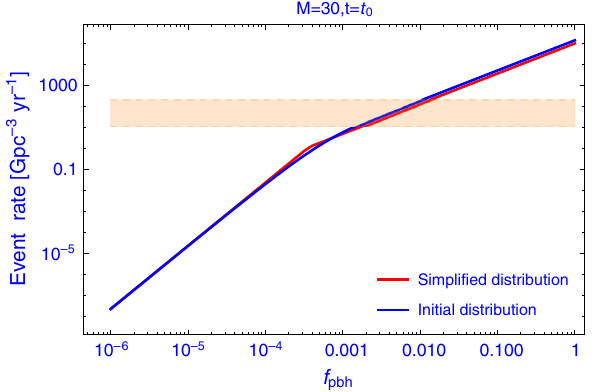
Fig. 1 Event rate of single-mergers of PBH binaries with the mass of 30 M (cid:2) asafunctionofthePBHabundance.Thebluelinecorrespondsto the case of the distribution (7) and the red line corresponds to the case of the distribution (8). The merger rate R = 12–213 Gpc − 3 year − 1 , inferred by the LIGO and Virgo Collaboration, is shown as the shaded region colored orange [29]